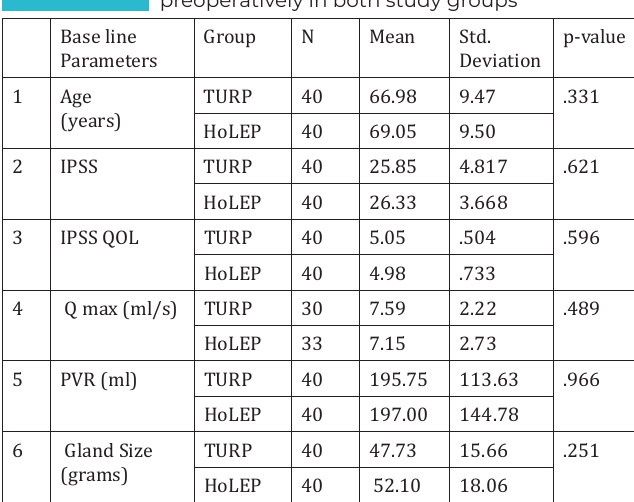
Comparision of base line parameters preoperatively in both study groups